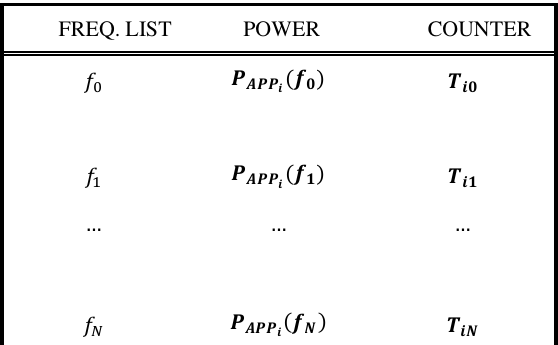
Table 1. AP-states FREQ. LIST